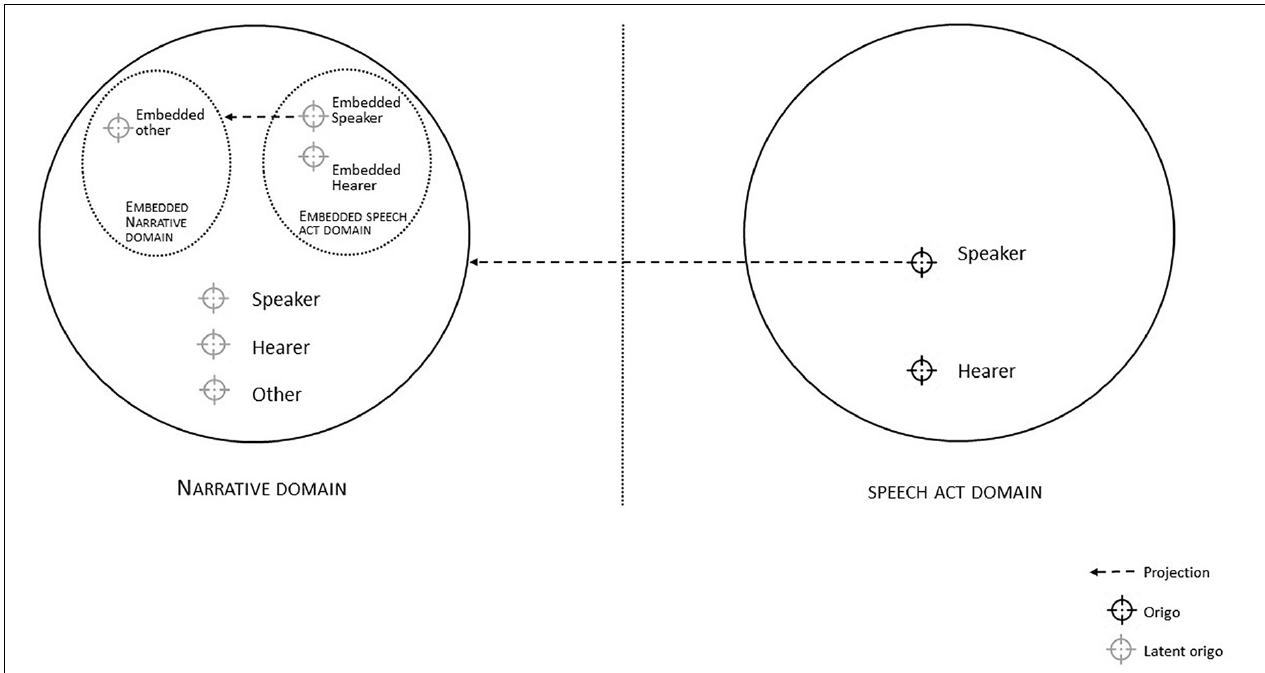
FIGURE 1 | Deictic Navigation Network with a Speech Act Domain representing the origos of Speaker and Hearer in the present and a Narrative Domain representing the origos of subjects that the discourse is